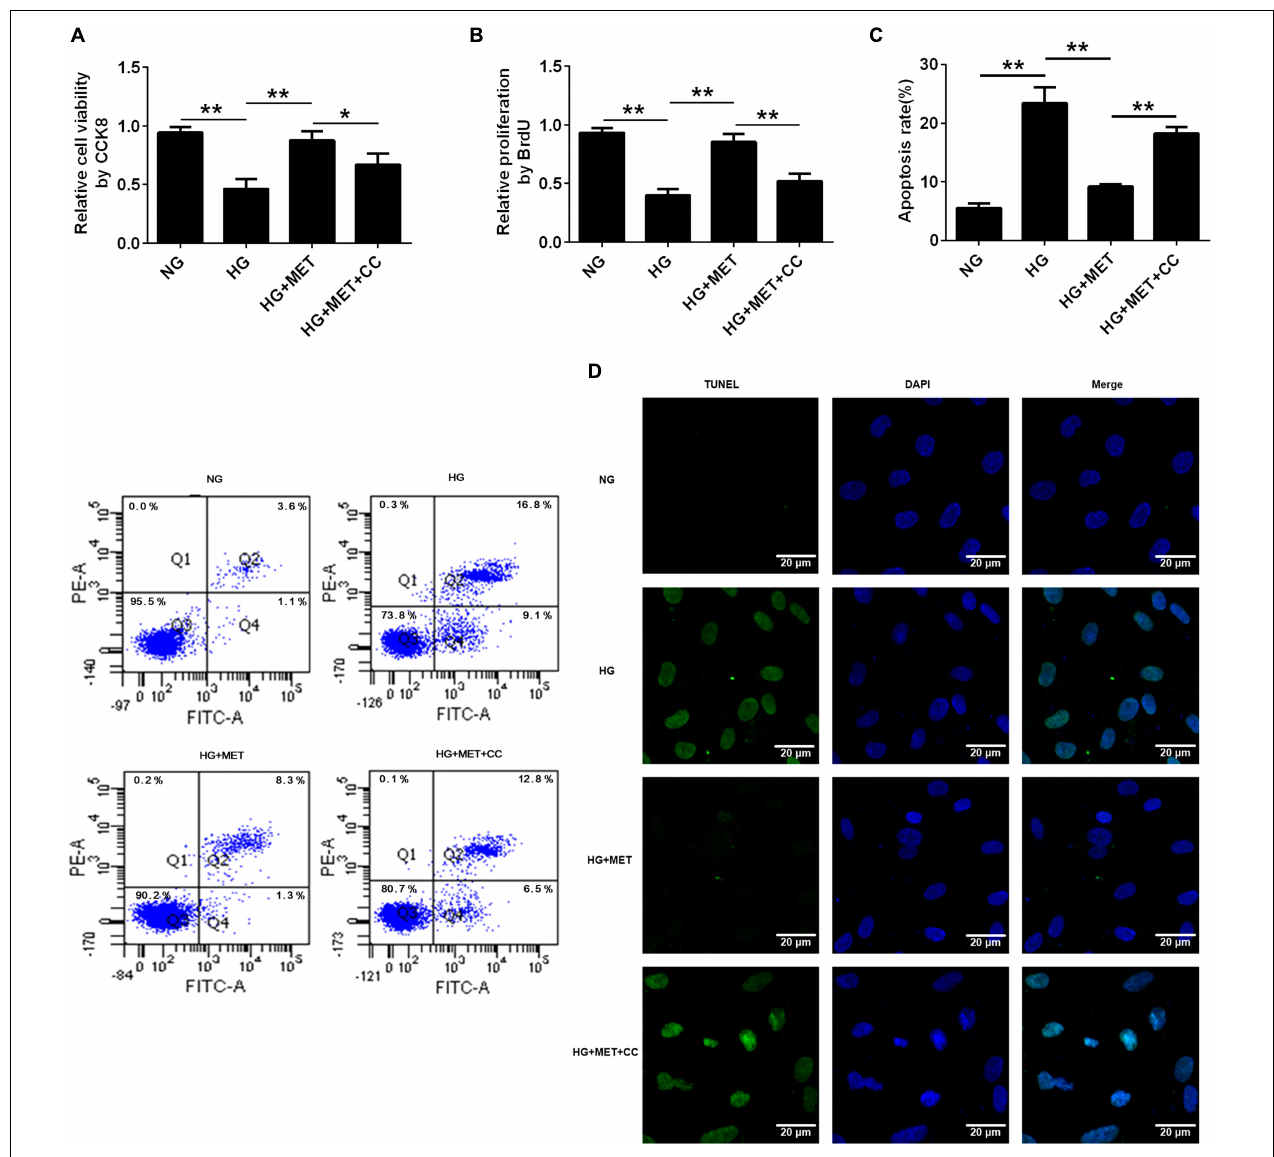
FIGURE 7 | AMPK was involved in the metformin-induced cell proliferation and apoptosis of HG-incubated HUVECs. (A) CCK8 assay in HUVECs treated with NG, HG (33.3 mmol/l), HG + MET (0.01 mmol/l), and HG + MET + CC (10 µ M) conditions. (B) BrdU incorporation assay in HUVECs treated with NG, HG, HG + MET, and HG + MET + CC. (C) Annexin V-PI assay in HUVECs treated with NG, HG, HG + MET, and HG + MET + CC. The histograms represent the apoptosis rates in the four groups. (D) Representative photographs of TUNEL staining in the different groups. The results are expressed as the means ± SD. ∗ p < 0.05, ∗∗ p < 0.01; one-way